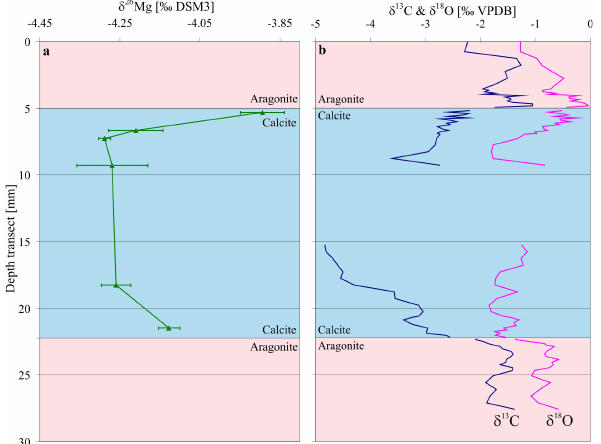
Fig. 9. Magnesium, carbon and oxygen isotope data and age data of flowstone SPA 52 from Spannagel Cave, Austria. Thick black lines indicate hiatuses. (a) Mg-isotope data (green) and age data (orange) plotted against distance from base in cm (age data from Sp¨otl et al., 2007). Red triangles indicate samples taken in detritus layers. (b) Carbon (dark blue) and oxygen (magenta) isotope data plotted against distance from base in cm (data from Sp¨otl et al., 2007). Marine isotope stages (MIS) after Sp¨otl et al. (2007).